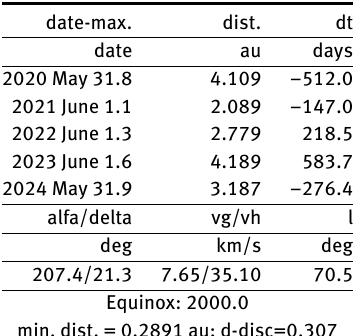
Table 6. 2008 LX16. Computed theoretical meteor shower